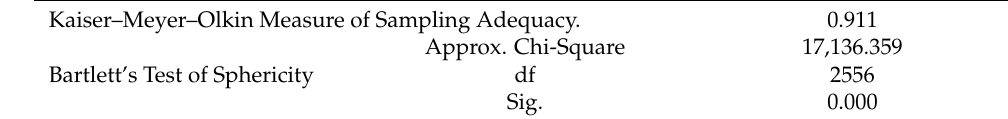
Table 5. KMO and Bartlett’s Test.